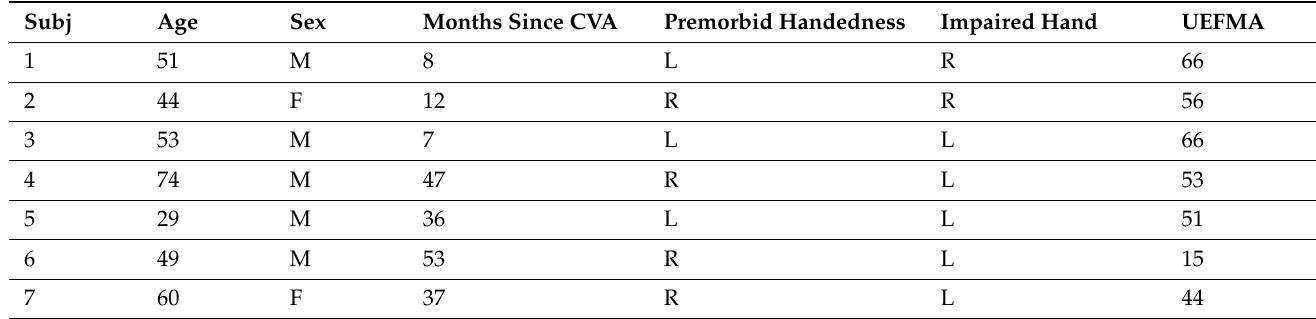
Table 1. Study #1 Subject